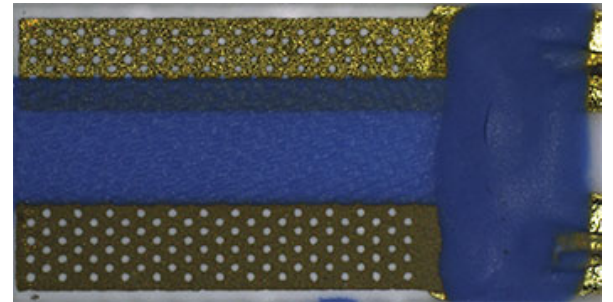
Figure 2. Top view of the mixed potential sensor; electrodes are printed on YSZ electrolyte, contacts made of gold.